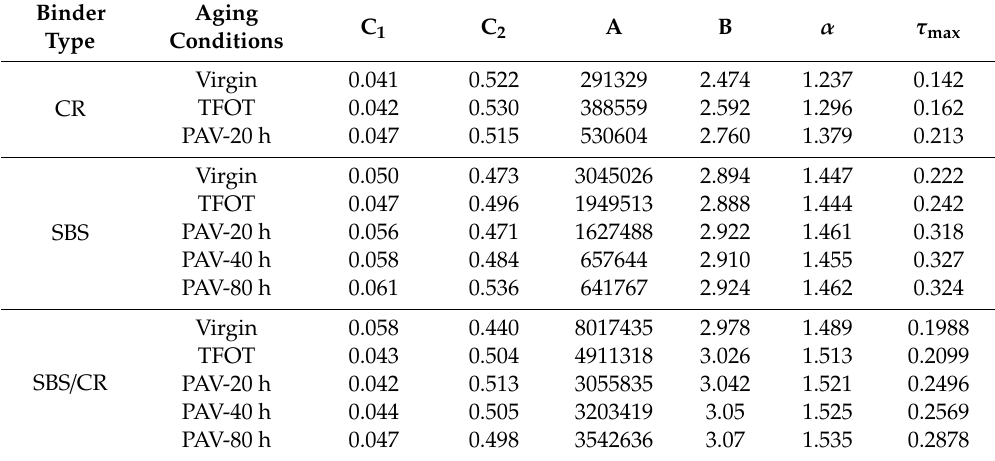
Table 3. LAS test results of all tested binders based on viscoelastic continuum damage